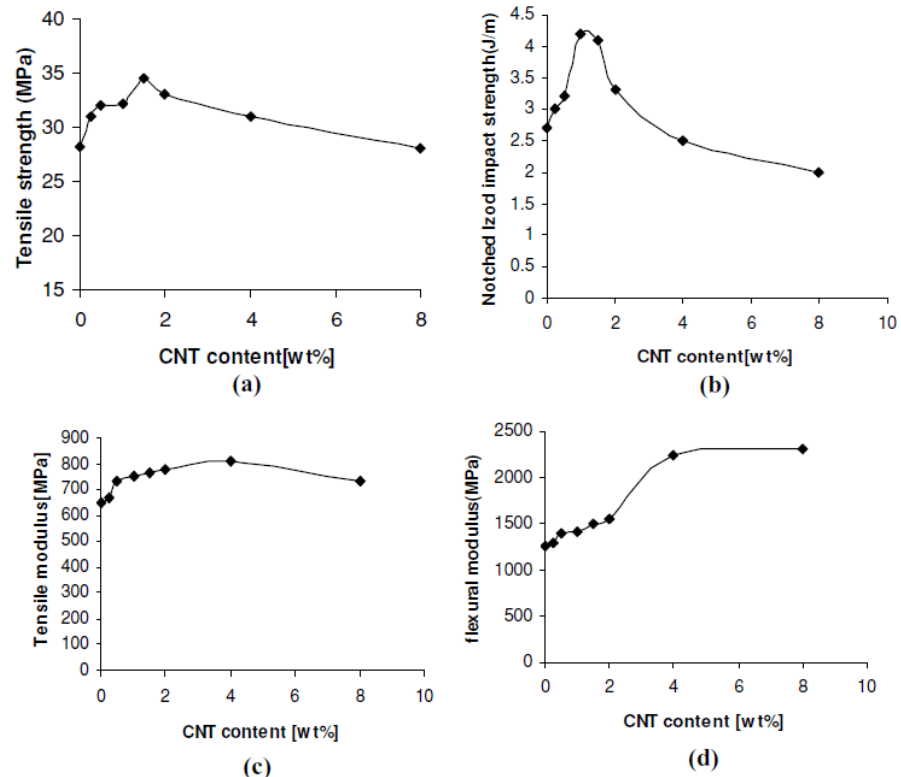
Figure 9. Mechanical properties of PP/CNTs nanocomposites. a) Tensile strength, b) notched Izod impact strength c), tensile modulus and d) flexural modulus. Reproduced with permission from